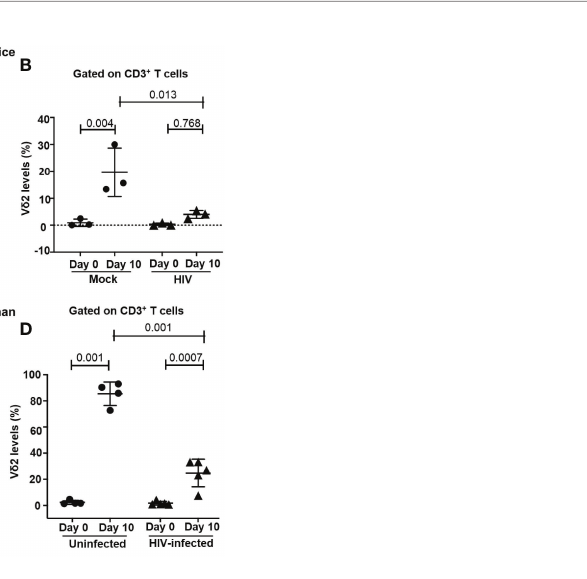
FIGURE 5 | HIV infection impairs the ex vivo expansion of V d 2 T cells. (A, B) BLT huMice were sacri fi ced at 4-6 weeks post-HIV/mock infection, and splenocytes isolated from the humanized spleen of BLT huMice were cultured in the presence of zoledronate IL-2, and uninfected allogenic monocytes (n = three mice per group). (C, D) Flow plots represent in vitro expansion of V d 2 cells from HIV-infected and non-infected individuals in the presence of zoledronate and IL-2. Expansion of V d 2 cell frequency was signi fi cantly higher in HIV-negative donors (n = 4) compared to HIV-positive donors (n = 5 biological replicates). Data are presented as mean values ± SEM. P values <0.05 were considered statistically signi fi cant as determined using a 2-way ANOVA